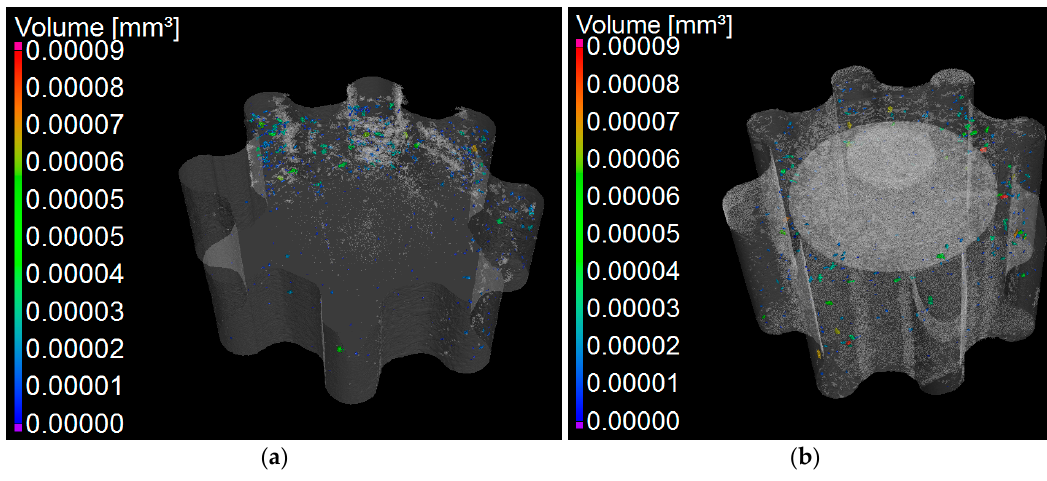
Figure 9. Volume pore distributions for ( a ) NPSG and ( b ) PSG. Deviation range from 0 to 0.00009 mm 3 .